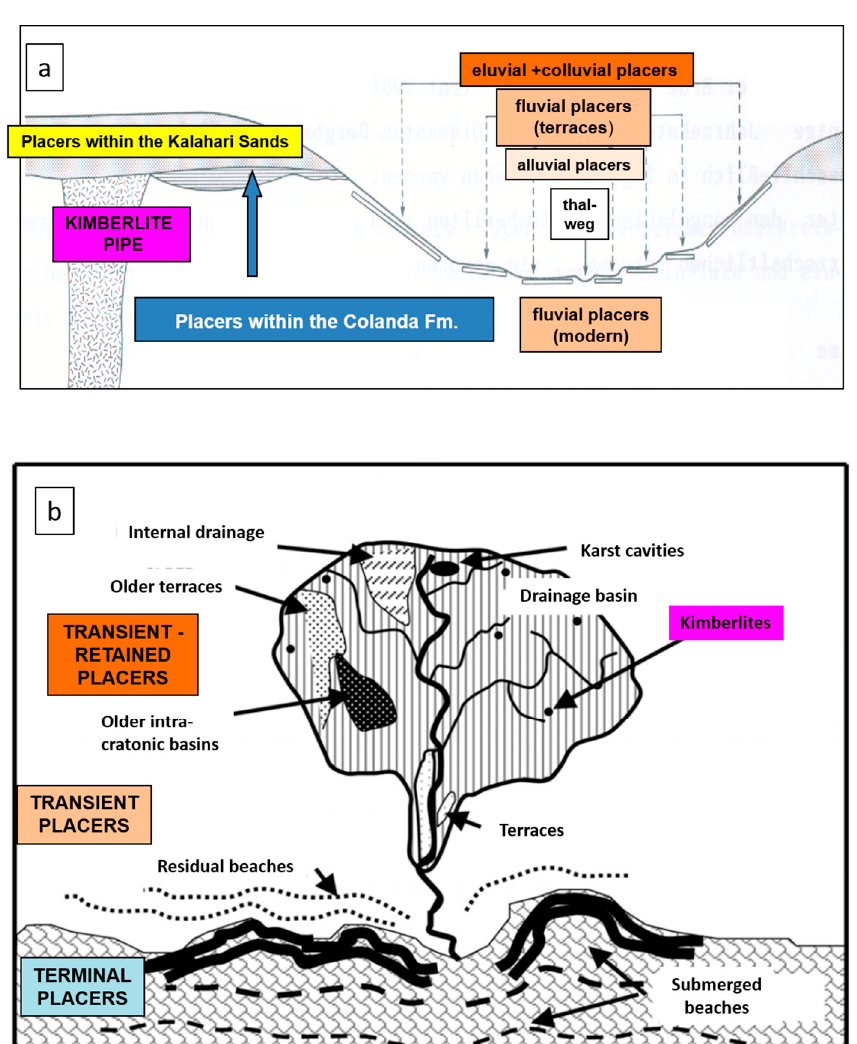
Figure 15. Diamond placer deposits in cross section [121]. ( a ) From the diamond-bearing pipe to the placer deposits. An idealized cross section illustrating the primary (kimberlite pipe), intermediate paleoplacers (Calonda and Kalahari placer sands) and final modern placer deposits of diamonds at midslope, footslope positions, and along the thalweg in the drainage systems in Angola (modified from [122]. ( b ) Cartoon to illustrate the tripartite subdivision of diamond placers into retained, transient, and terminal placer deposits leading to the modern-day mega-placers in Southern Africa (modified from [106]).